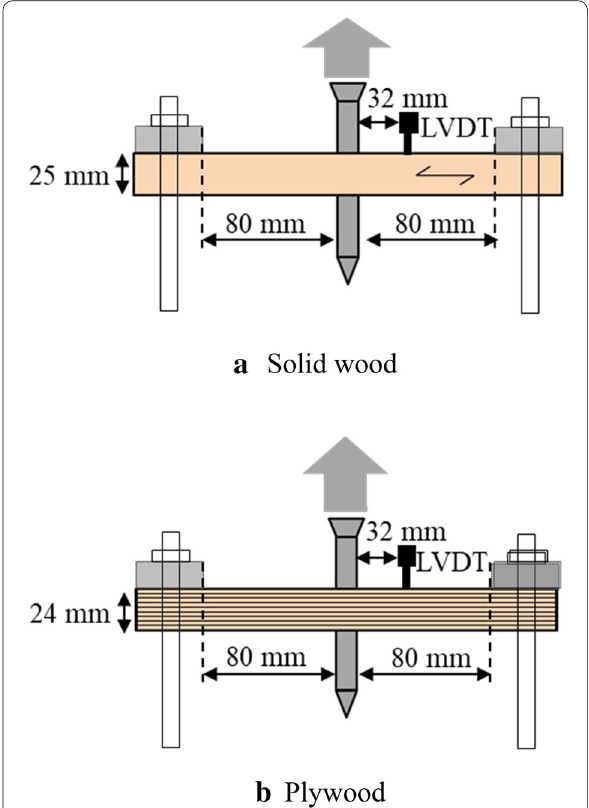
Fig. 3 Withdrawal test configurations for solid wood and plywood